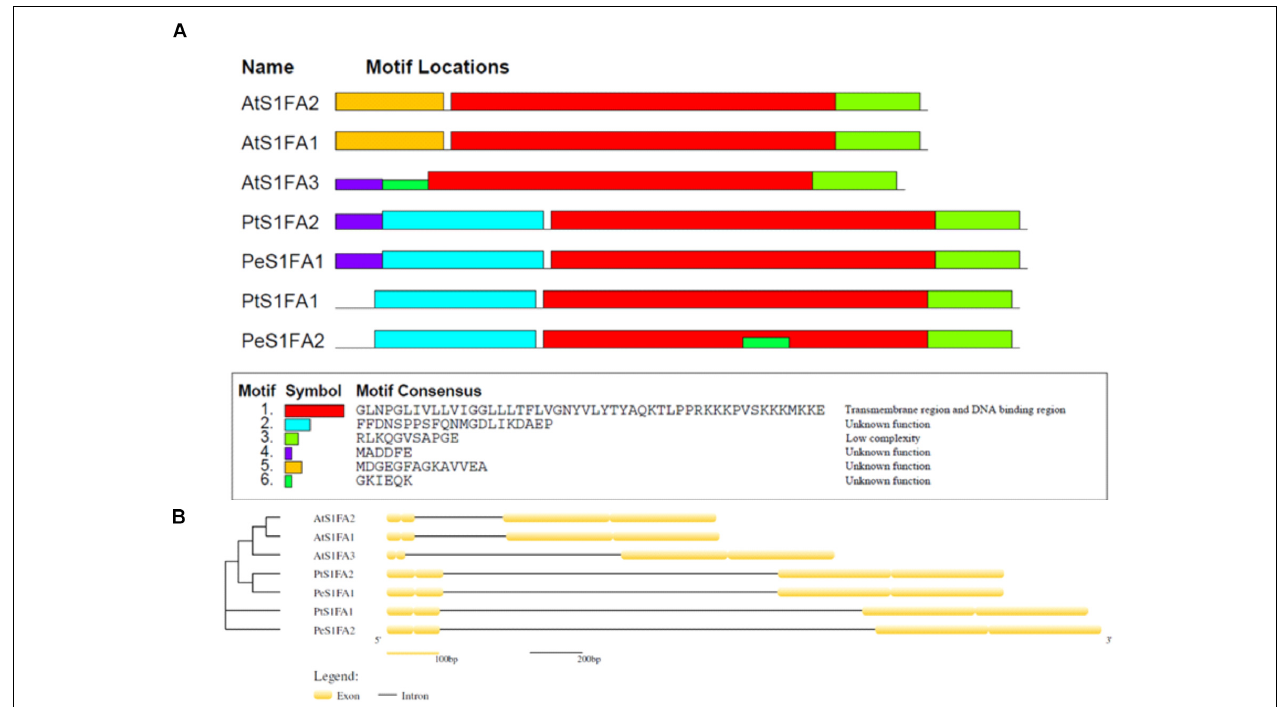
FIGURE 2 | The protein motifs and gene structures of S1Fa-like gene family from poplar. (A) The protein motifs of the S1Fa-like family members. Different motifs were sketched with different colorful box. Clustering was carried out based on the phylogenetic results. (B) Gene structures. Exons and introns are displayed using yellow boxes and Black solid lines,